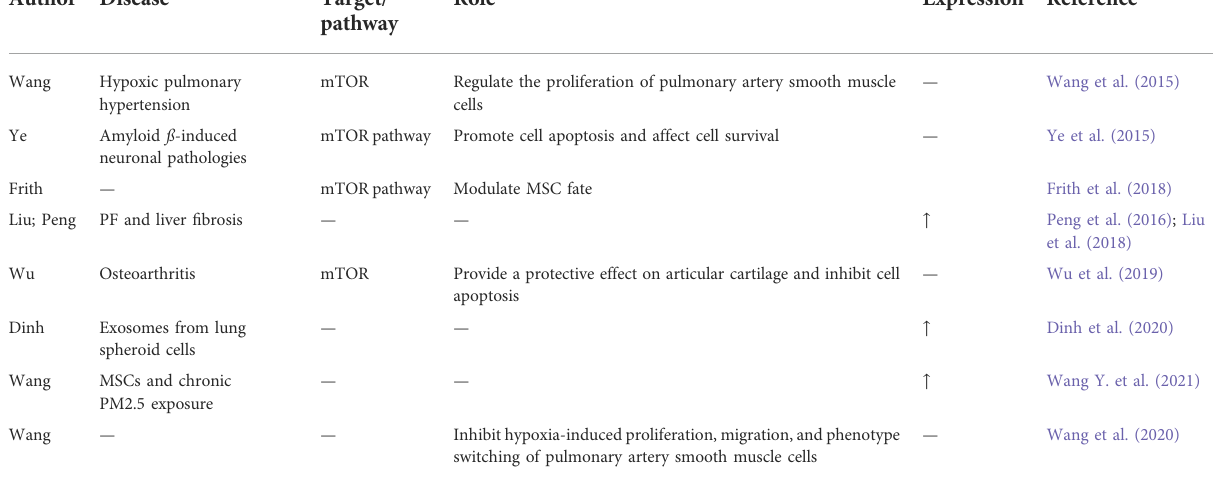
TABLE 5 The roles of miR-100-5p in lung